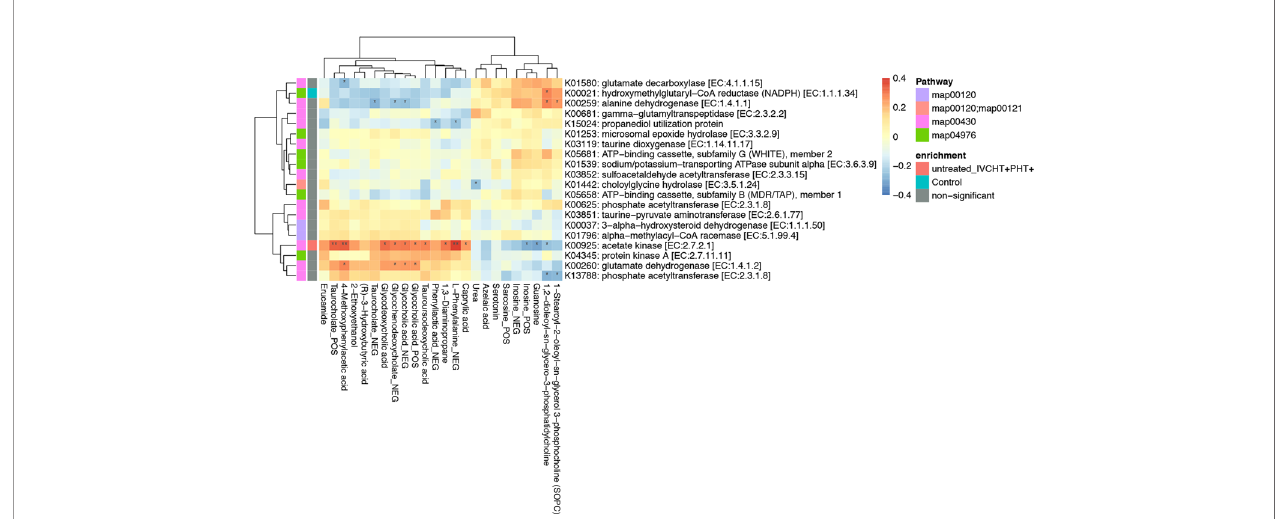
FIGURE 4 | Taurocholate showed signi fi cant positive correlation with K00925: Acetate kinase [EC:2.7.2.1] of Campylobacter concisus . *P < 0.05, **P < 0.01, enrichment direction as